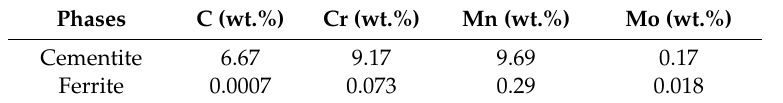
Figure 2. Isopleth of the phase diagram of CrMo steel calculated using Thermocalc ® software. The dashed line indicates the carbon (C) content. The equilibrium A 1 and A 3 temperatures are defined also (720 ◦ C and 760 ◦ C respectively). Table 3. Initial chemical compositions of cementite (5 nm, 200 nm, 500 nm) and ferrite calculated at 500 ◦ C.